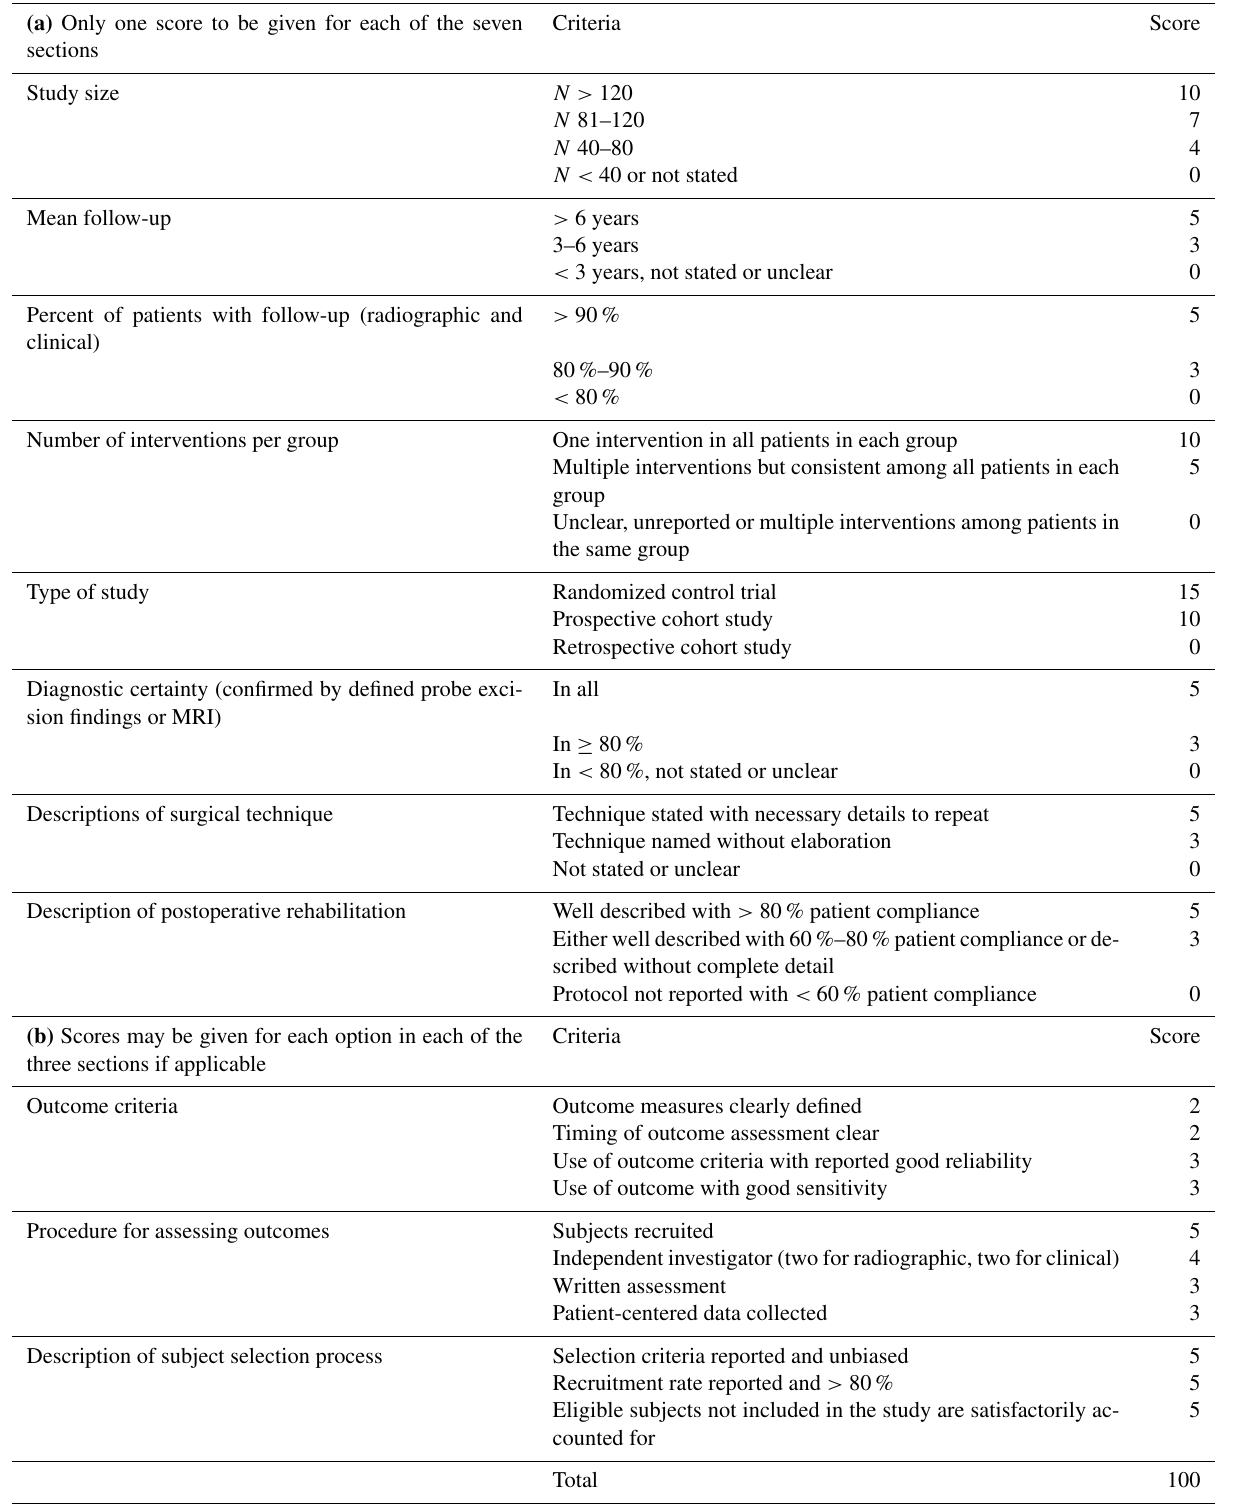
Table 5. Modified Coleman methodology